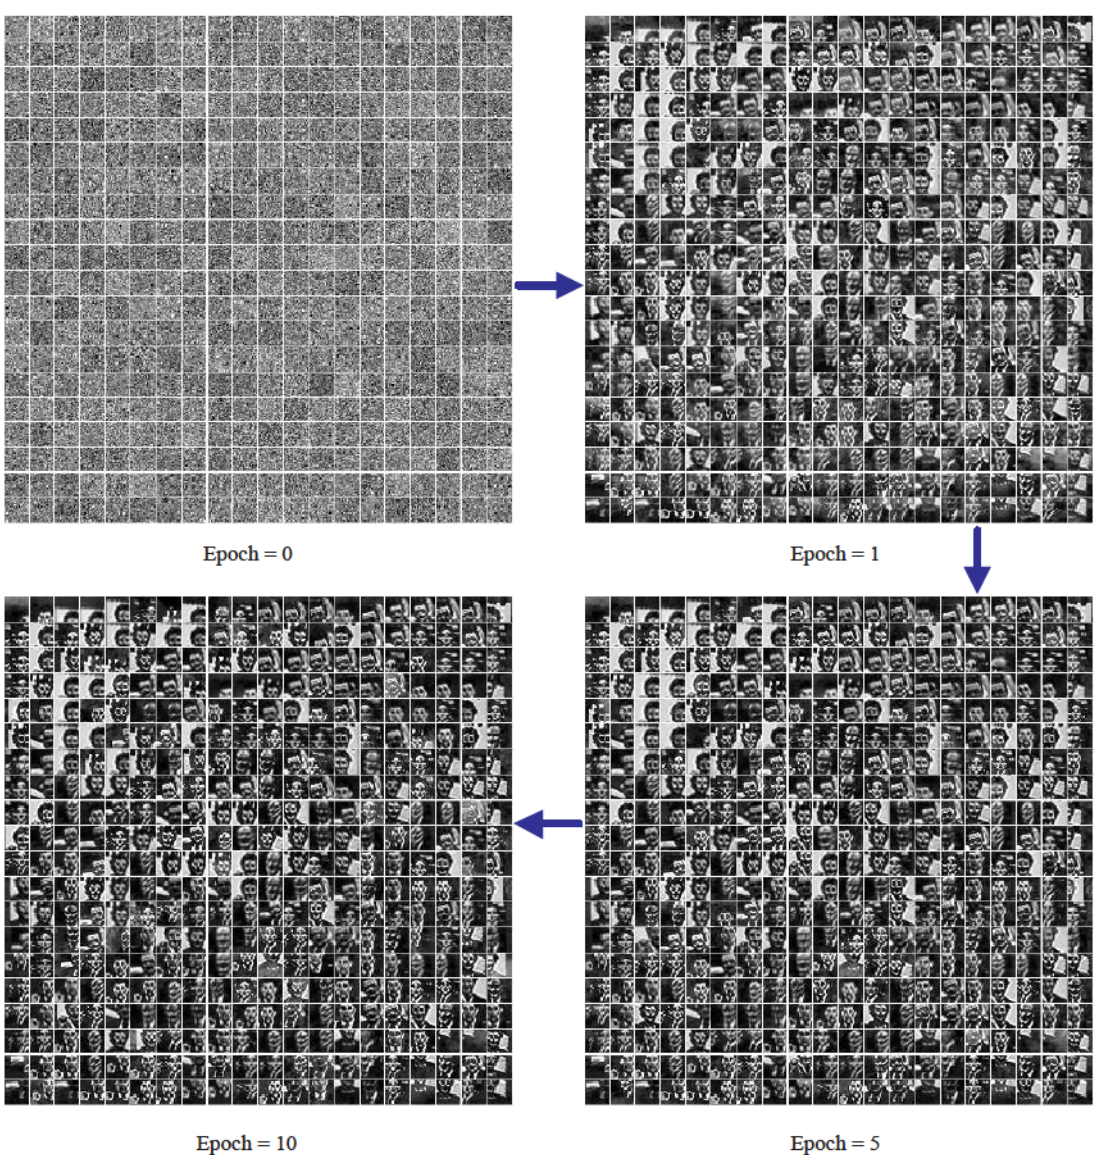
Figure 7: Visualization of the weight value from X layer to Y layer under different epochs.